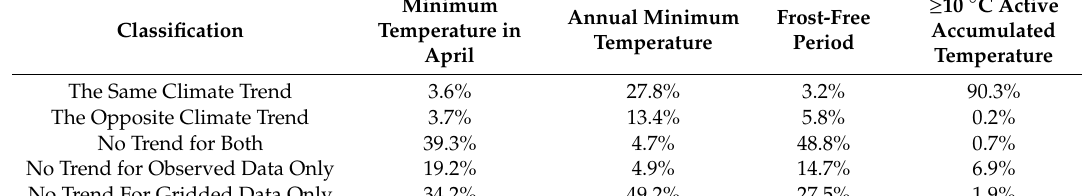
Table 5. Trend statistics (the percentage) between observed data and gridded data in mainland China.